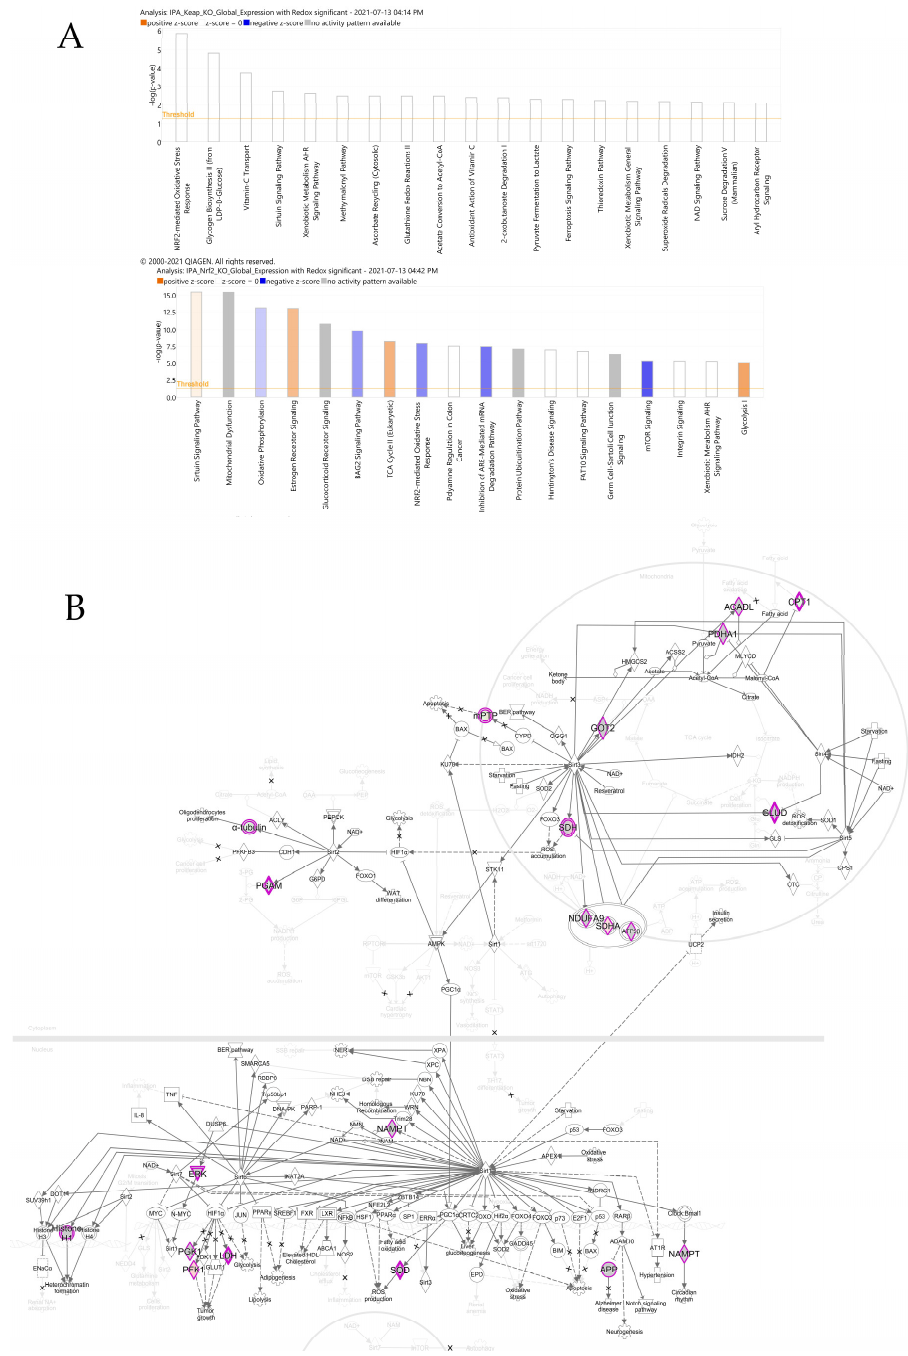
Figure 3. Canonical pathway analysis of differentially expressed proteins in Nrf2-KO and Keap1-KO. ( A ) Benjamini–Hochberg false discovery rate-corrected IPA pathways differentially expressed in Nrf2 KO (upper panel) and Keap1-KO mice (lower panel). The x-axis represents the IPA pathways that were identified, and the y-axis shows the –log p of the value calculated based on Fisher’s exact test with multiple correction. Orange bar indicates that the pathway was activated. Blue bar indicates that the pathway was inhibited. Grey bar indicates that there is no measurable change. ( B ) Nrf2-KO pro- teins significantly differentially expressed in sirtuin signaling pathway. Upregulated/downregulated proteins are highlighted in magenta